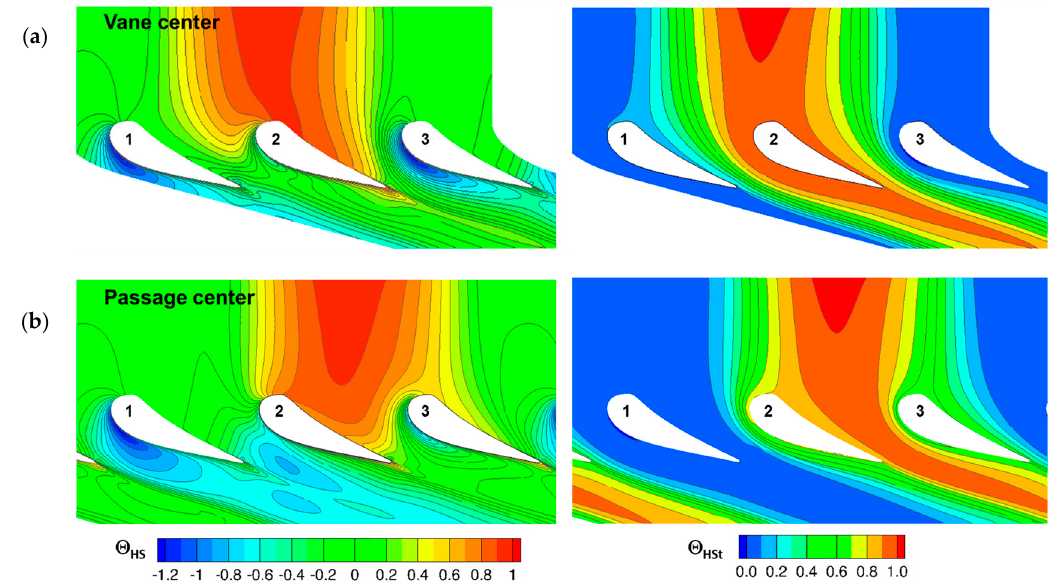
Figure 9. Predicted temperature ratio ( Θ HS and Θ HSt ) at midspan ( Z/H = 0.5) for the hot streak aligned with the vane ( a ) or passage center ( b ).